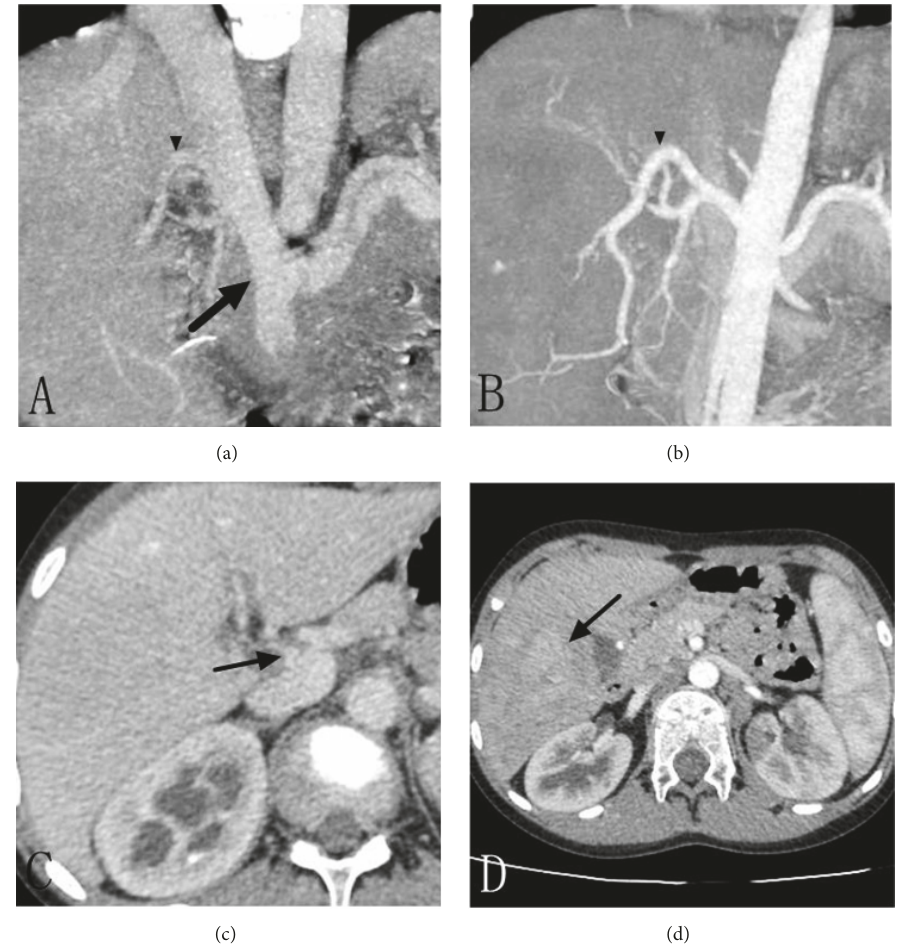
Figure 1: (a) The splenic vein and superior mesenteric vein drained directly into the inferior vena cava after confluence (arrow). (b) Note that the branch overlapping with the portal vein in (a) originated from the hepatic artery, not from the portal vein (arrow head). (c) A barely perceptible small branch of the portal vein measuring only 3 mm supplied the left lobe of the liver (arrow). (d) A faintly visible mass in segment 5 approximately 55 mm in size and poorly demarcated with mildly heterogeneous enhancement on arterial phase (arrow), which conferred a diagnosis of tumour